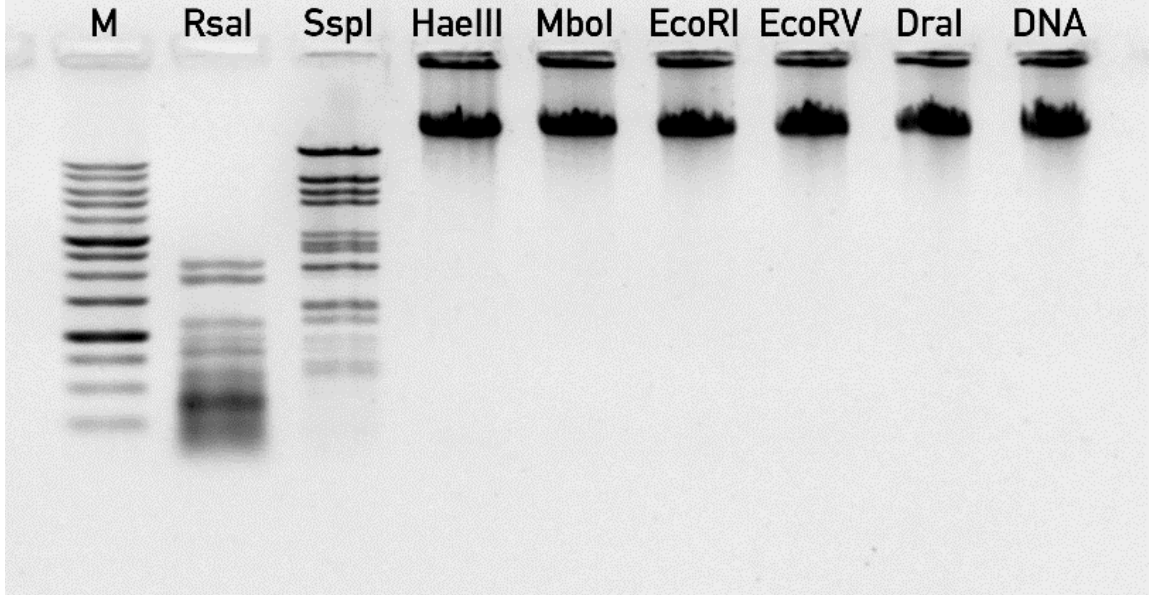
Figure 6. The digestion of bacteriophage 9g DNA by restriction endonucleases. “M” lane—1 kb DNA ladder (SibEnzym, Novosibirsk, Russia), “DNA” lane correspond